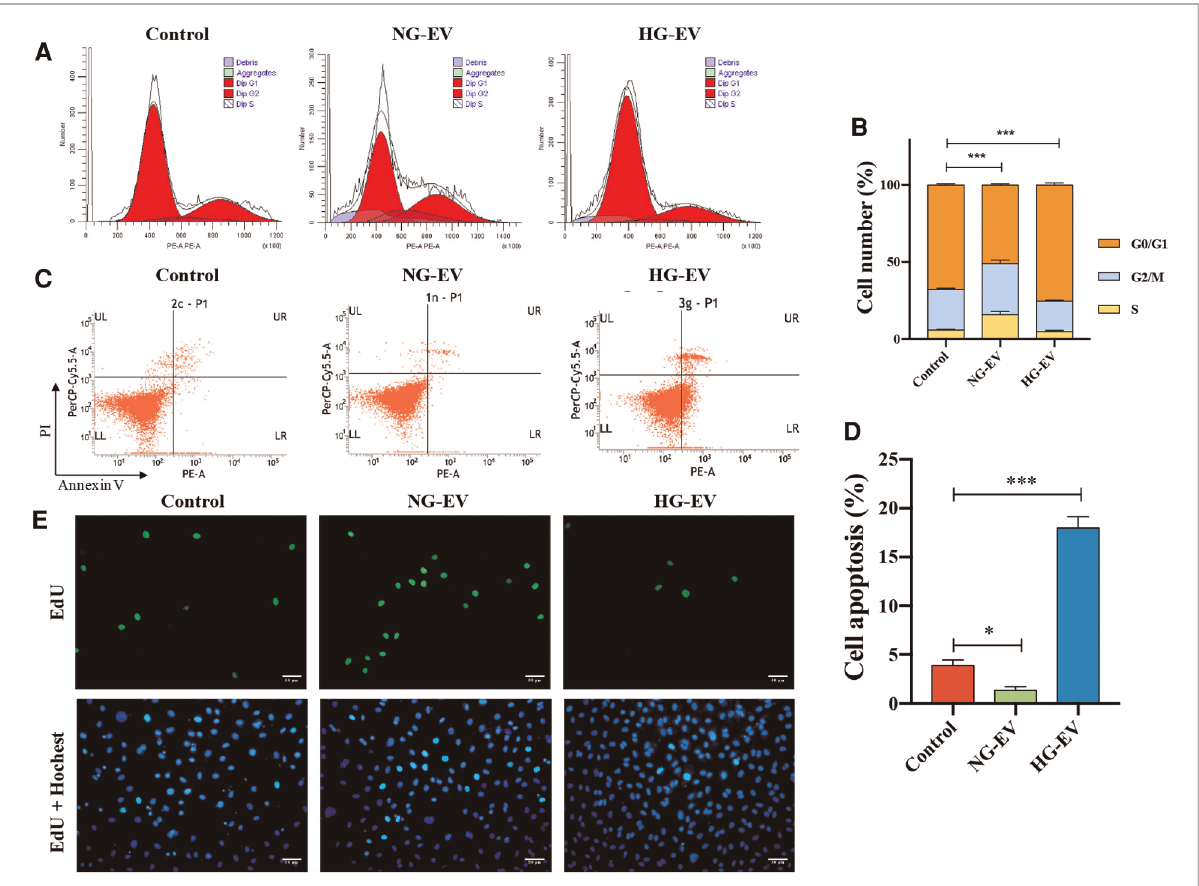
FIGURE 2 The effects of EVs on HUVECs proliferation. ( A ) Flow cytometric analysis of cell cycle. ( B ) Flow cytometric analysis of cell apoptosis. ( C ) The percentage of HUVECs in the G0/G1, S and G2/M phases, respectively ( n =5). ( D ) The statistical analysis of the percentage of EdU positive cells ( n =5). ( E ) EdU positive cells (green) and nuclei (blue) in each